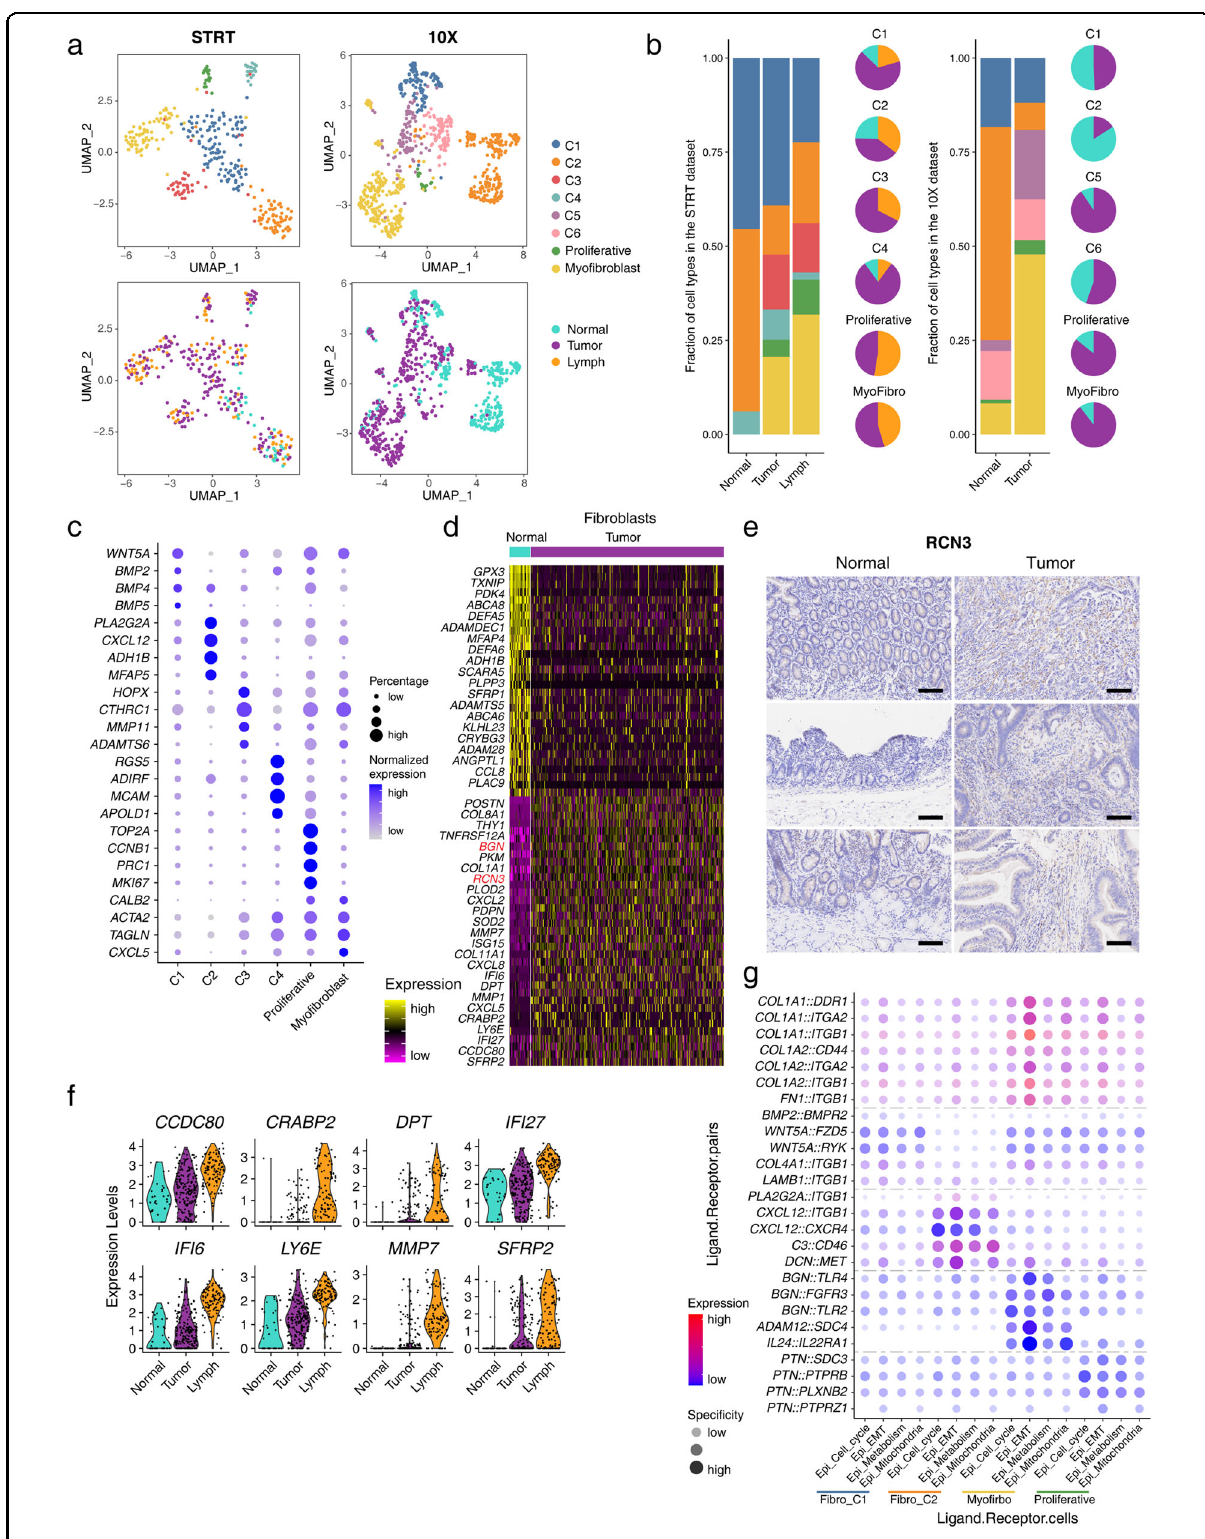
Fig. 4 (See legend on next